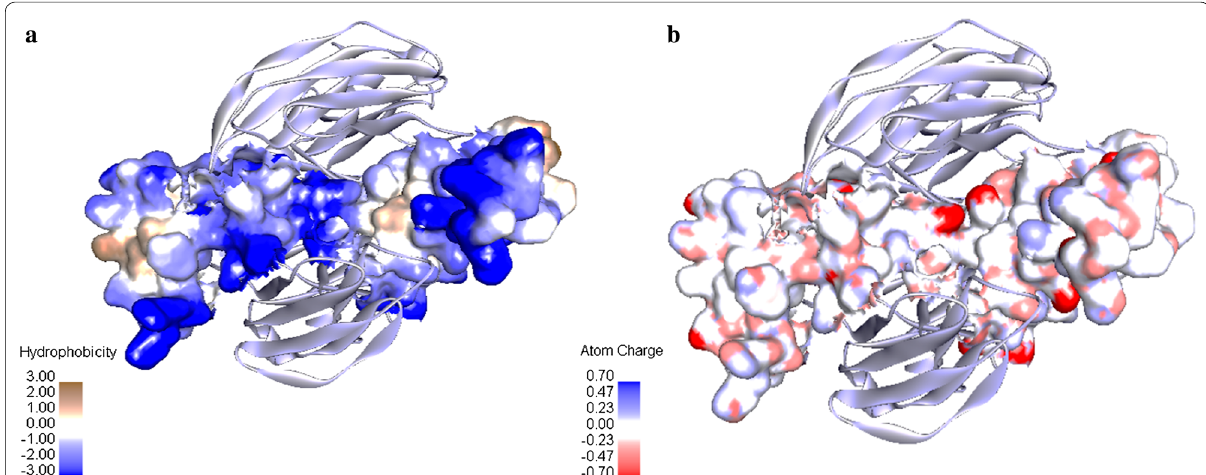
Fig. 4 a The hydrophobic surface display of interaction of SpA with IgG Fc , b The electrostatic surface display of interactions SpA with IgG Fc